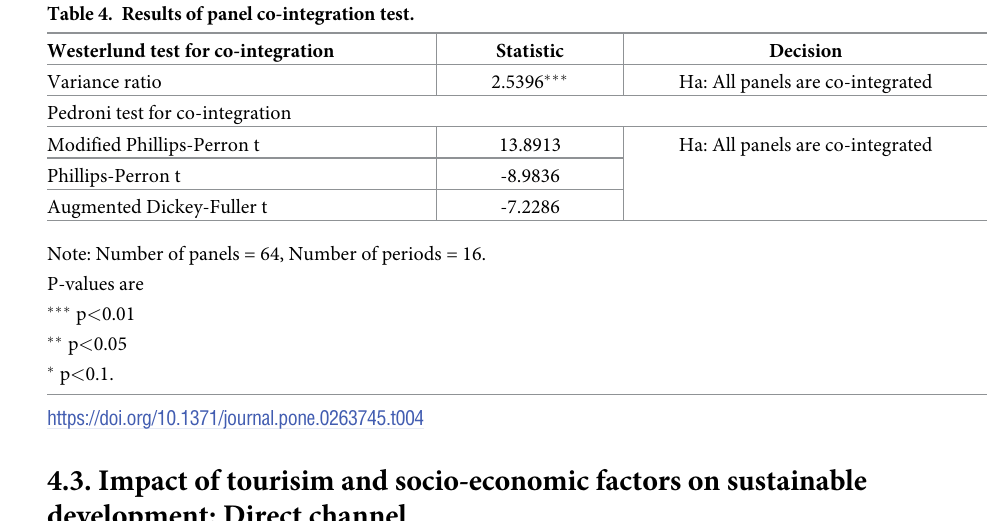
OLS, fixed-effects models, and two-step system GMM. Static pooled OLS in column 1 demon-